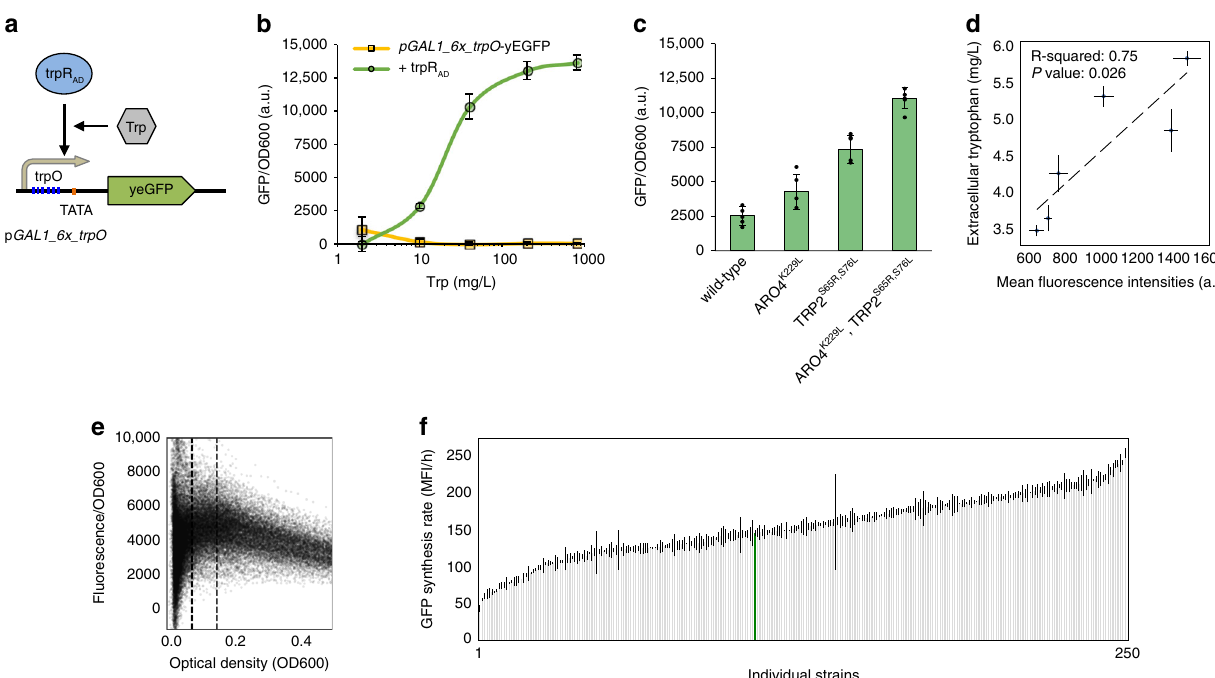
Fig. 3 Phenotypic library characterization using an engineered tryptophan biosensor. a Schematic illustration of the design of the tryptophan (Trp) biosensor (trpR AD ) engineered in this study. The trpR AD indicates the engineering tryptophan biosensor composed of the E. coli TrpR fused to the GAL4 activation domain. The biosensor regulates an engineered reporter (yeGFP) GAL1 promoter, including 6× copies of TrpR binding sites ( trpO ), placed upstream of the TATA box of GAL1 promoter ( pGAL1_6x_trpO ). b Fluorescence normalized by optical density (OD 600 ) for two strains related to concentration of tryptophan supplemented media (mean fl uorescence intensity/OD, MFI/OD with standard errors, n = 3 biological replicates). Both strains contain the yeGFP reporter under the control of the pGAL1_6x_trpO reporter promoter, and only one strain expresses the Gal4 activation domain fused to trpR (in green). c Fluorescence normalized by OD 600 for a wild-type strain and strains with expression of feedback-resistant versions of ARO4 and TRP2 , ARO4 K229L and TRP2 S65R,S76L , respectively (mean fl uorescence intensity, MFI/h with standard errors, n = 4 – 5 biological replicates). d Extracellular tryptophan normalized by OD 600 related to fl uorescence normalized by OD 600 (mean values with standard errors, n = 3 technical replicates).The p -value showing a signi fi cant slope is from a two-sided t -test performed on mean values for the six different genotypes. e Fluorescence divided by OD 600 related to OD 600 for library and control strains. Dashed lines are shown at OD 600 equals 0.075 and 0.15. f Measured mean green fl uorescent protein synthesis rate. MFI/h with standard errors, n = 3 technical replicates. The data is ranked according to increasing mean rate. The strain with fi ve native promoters expressing the fi ve candidate genes is highlighted in green. GFP green fl uorescent protein, MFI mean fl uorescence intensity, OD 600 optical density (600 nm), a.u. arbitrary units. Source data underlying Fig. 3b – f are provided as a Source data fi